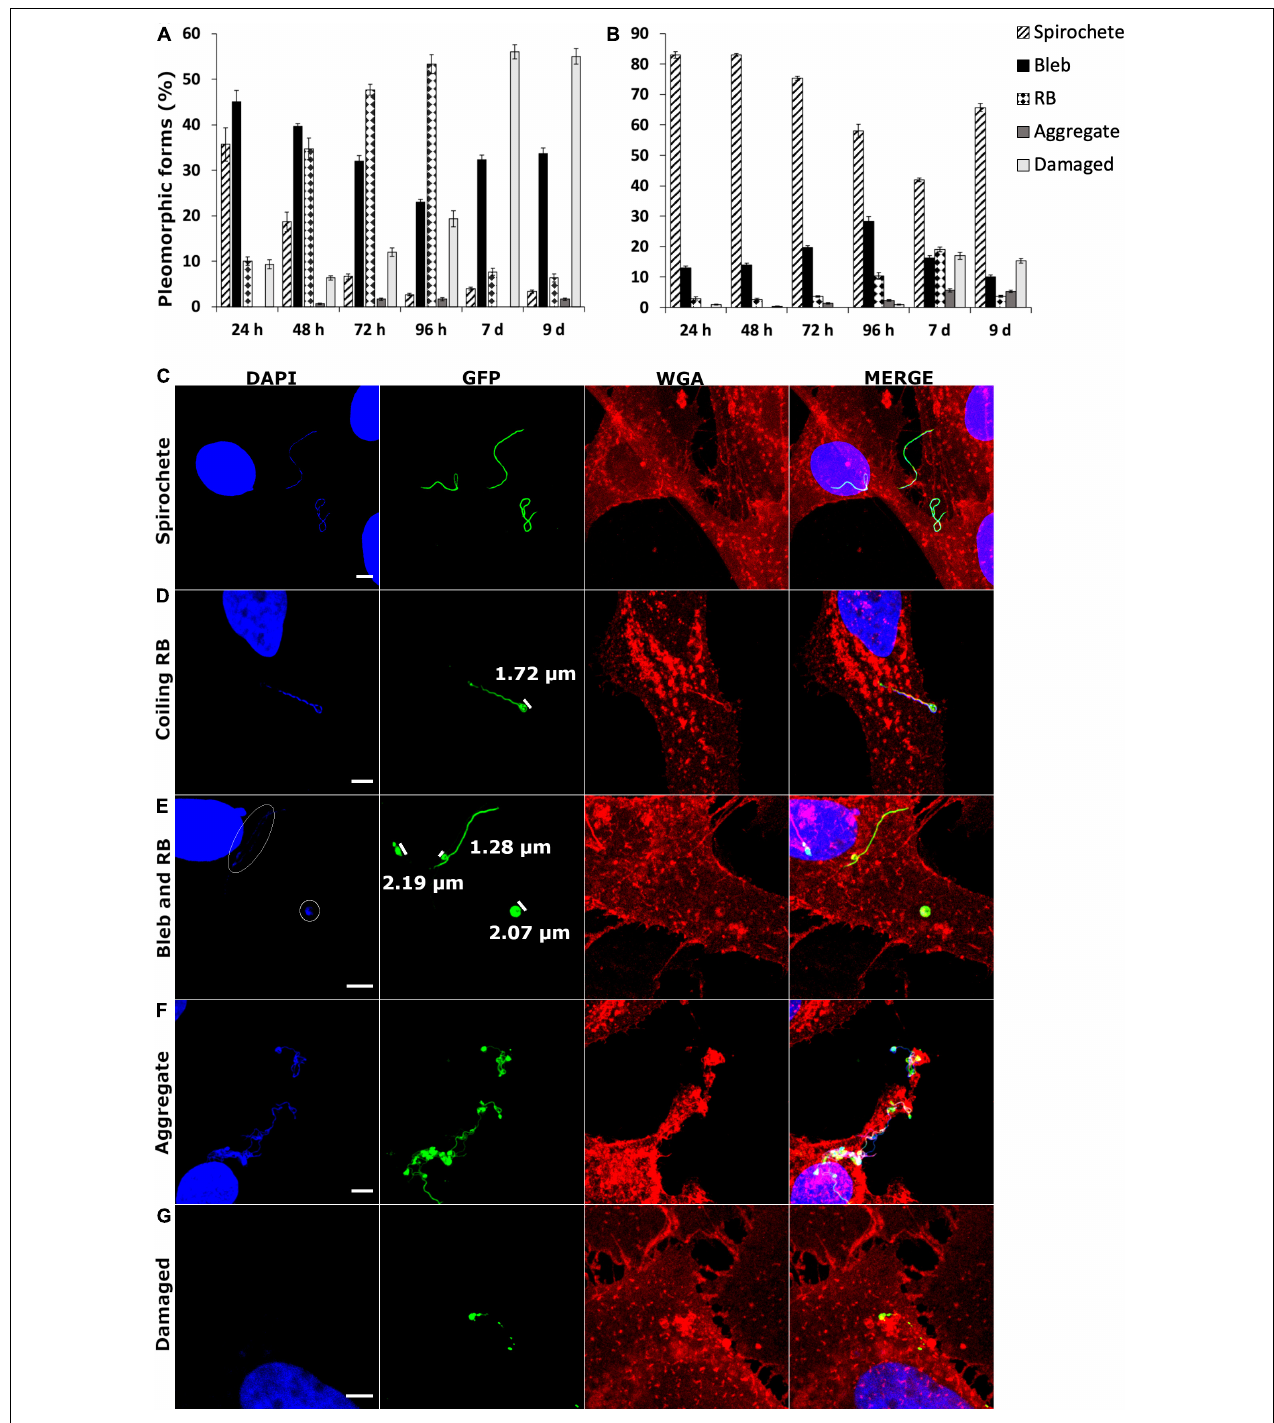
FIGURE 7 | Borrelia burgdorferi infection resulted in different formation of pleomorphic forms between the two human cell lines. SW1353 (A) and BJ (B) cells were infected with B. burgdorferi at several time points. A total of 300 B. burgdorferi from three experiments were calculated and characterized into spirochete, bleb, round body (RB), aggregate, and damaged categories (the different category definitions can be found in Table 1 in the “Materials and Methods” section). Different pleomorphic forms in the two human cell lines were observed. (C) Three spirochetes are evident, while in panel (D) , a coiling RB is visible with the coiling head measuring 1.72 µ m. Comparison with a bleb (1.28 µ m) to an RB (approximately 2.0 µ m) are demonstrated in panel (E) . DNA signal from the RB on the right, as well as, from the bleb are indicated in white circles. An aggregate is represented in panel (F) , while panel (G) indicates a damaged B. burgdorferi with a clear lack of bacterial DNA. DNA is visualized in blue (DAPI), B. burgdorferi in green (GFP) and the cell membrane in red (WGA). Merged images of the channels are provided. Scale bars 5 µ m.